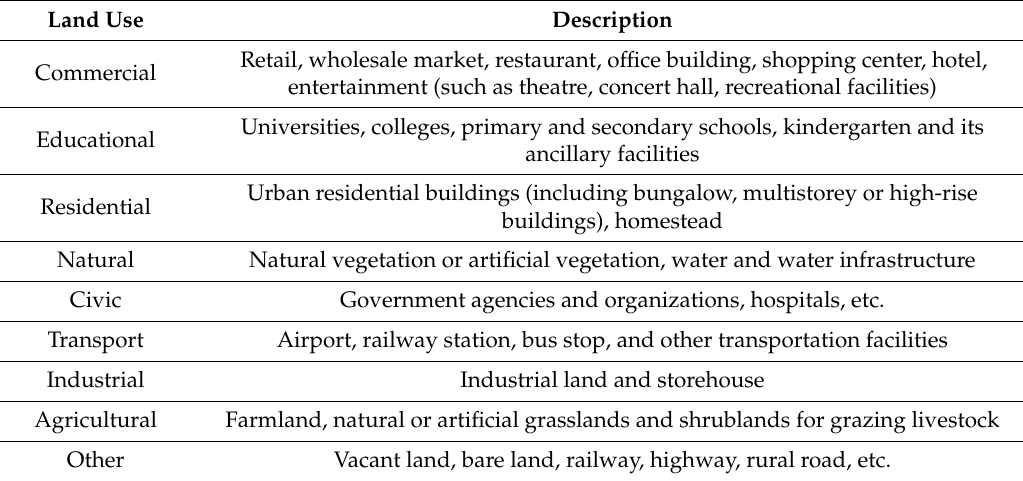
Table 1. Classification criteria for urban land use types.